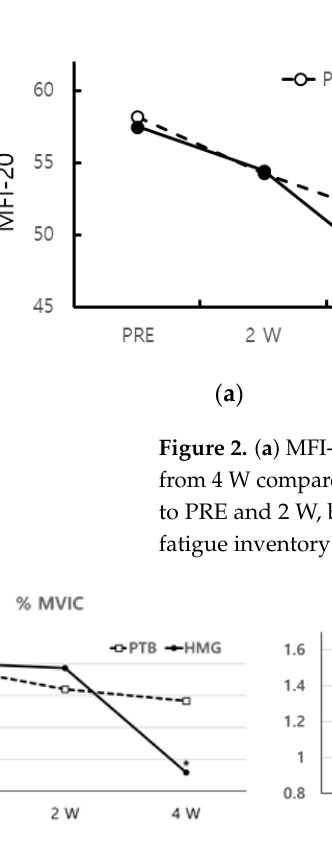
Figure 3. ( a ) The levels of the normalized sEMG signals (%MVIC) were significantly decreased at 4 W in both groups. However, there was a decrease in the HMG compared to the PTG at 4 W ( p <